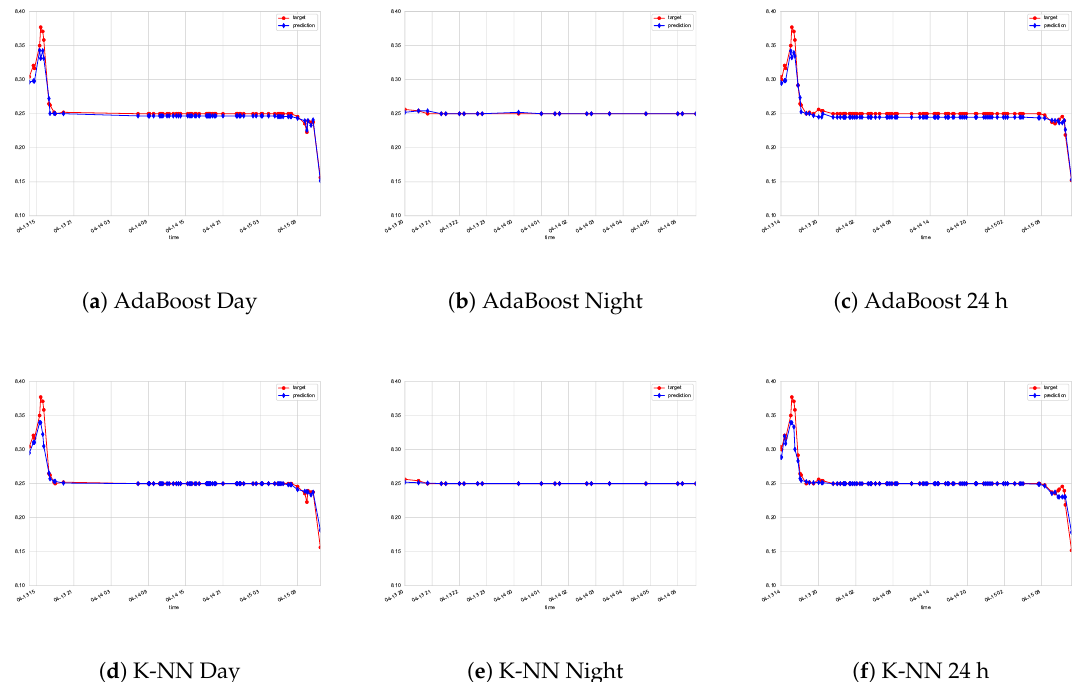
Figure 5. Actual data vs. predictions for Experiment A. AdaBoost and k-nearest neighbors are considered for each model (day, night, and global